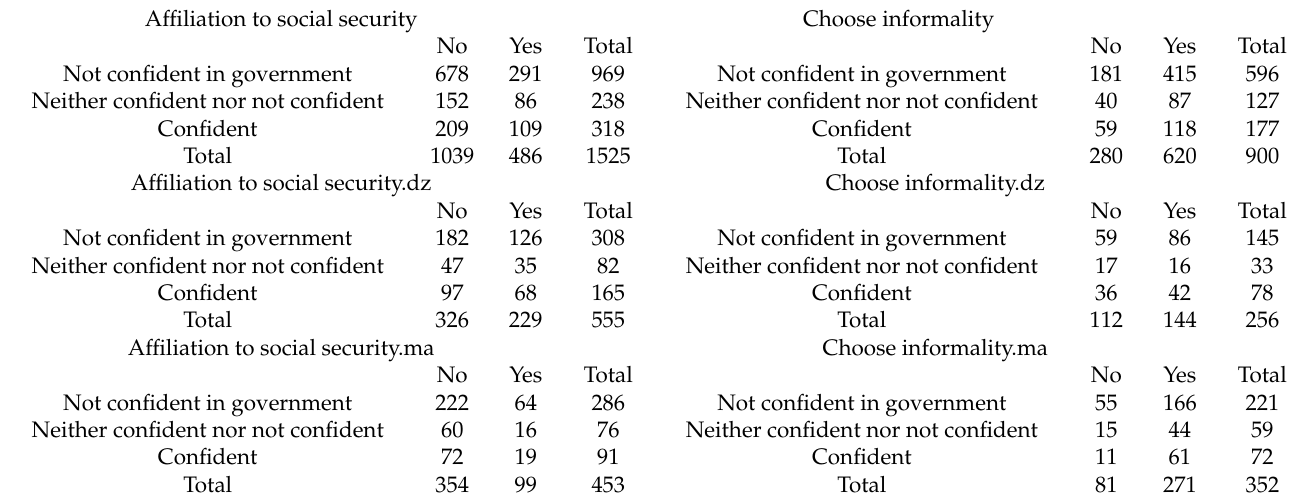
Table A4. Affiliation to social security and the reason for not being insured, according to confidence in government. Source: Sahwa